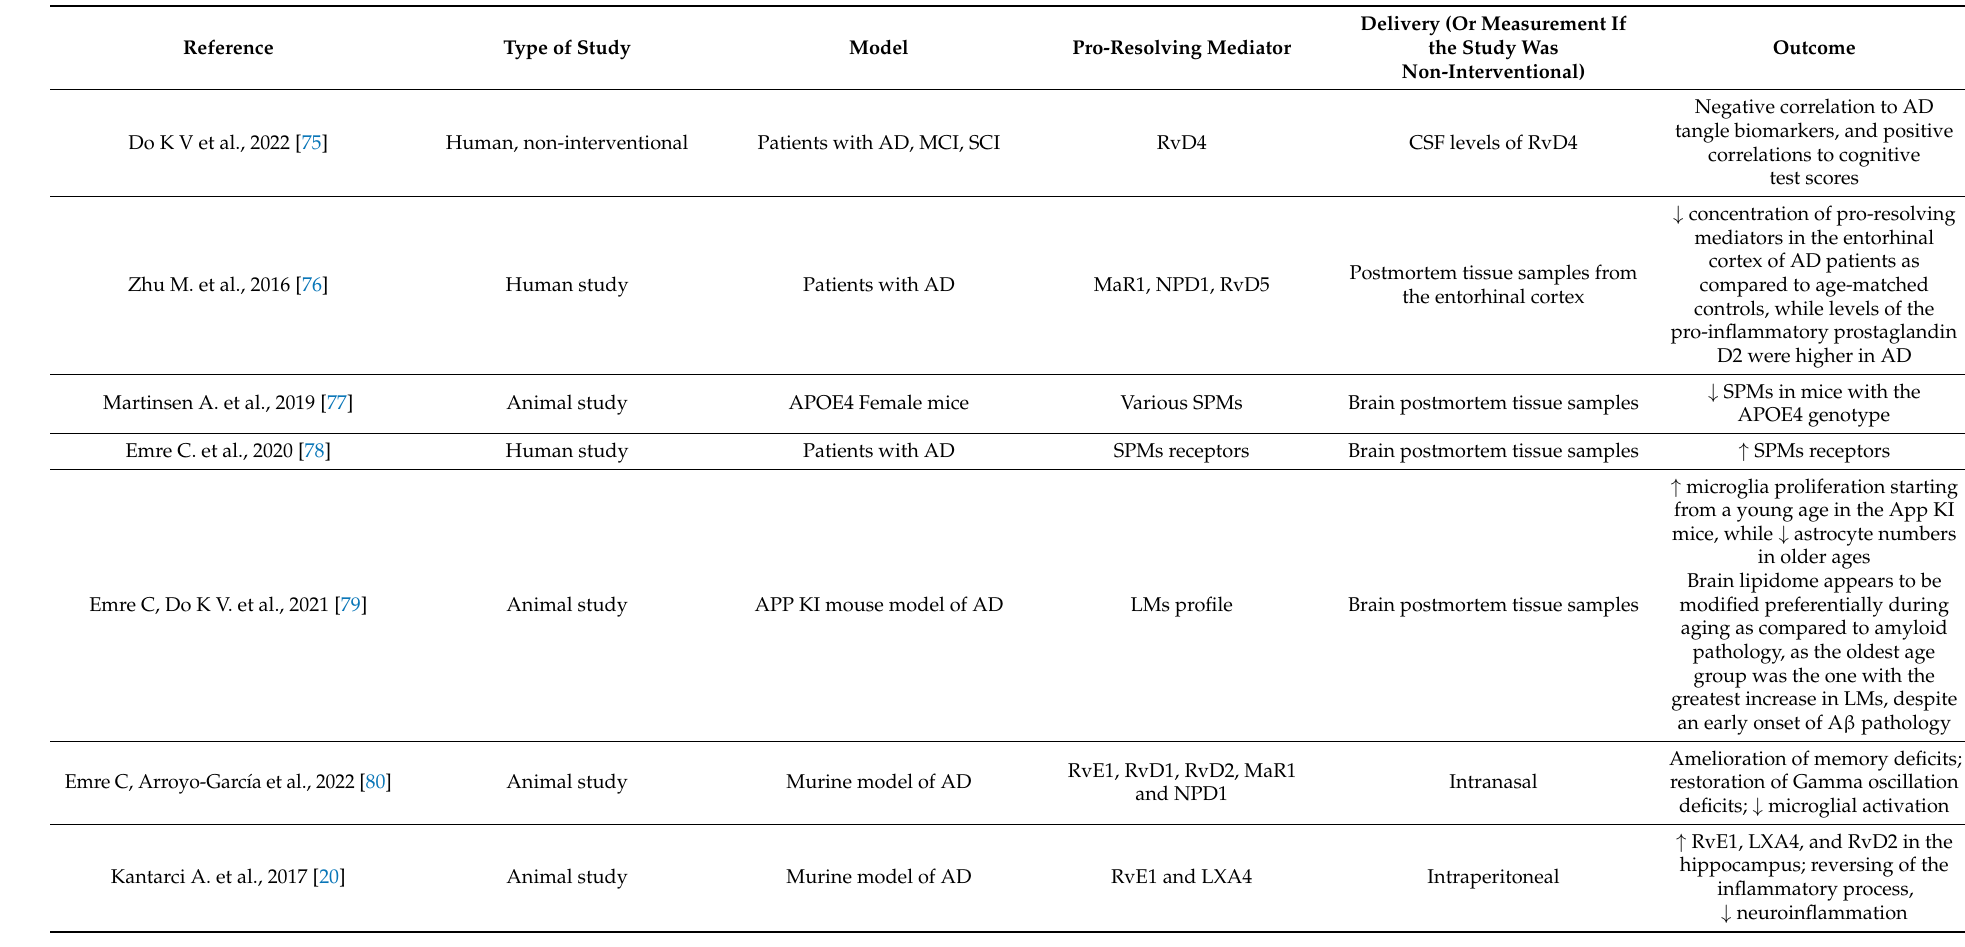
Table 3. Summary of in vivo studies on SPMs in neurodegenerative